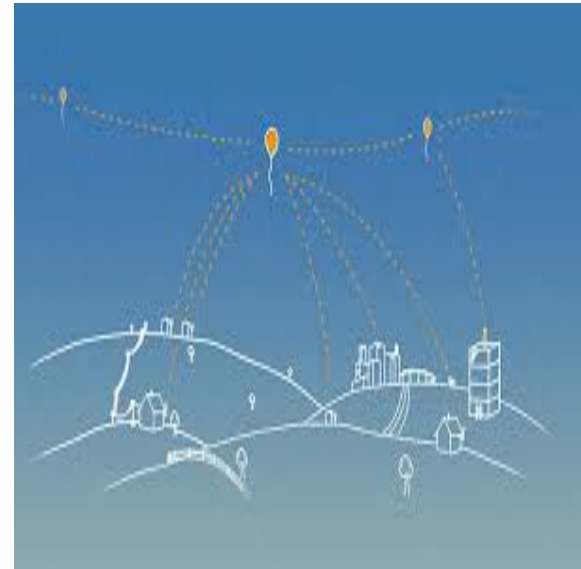
Figure 2. Google balloons for Internet in rural areas